Question: What style of plot is this figure drawn as?
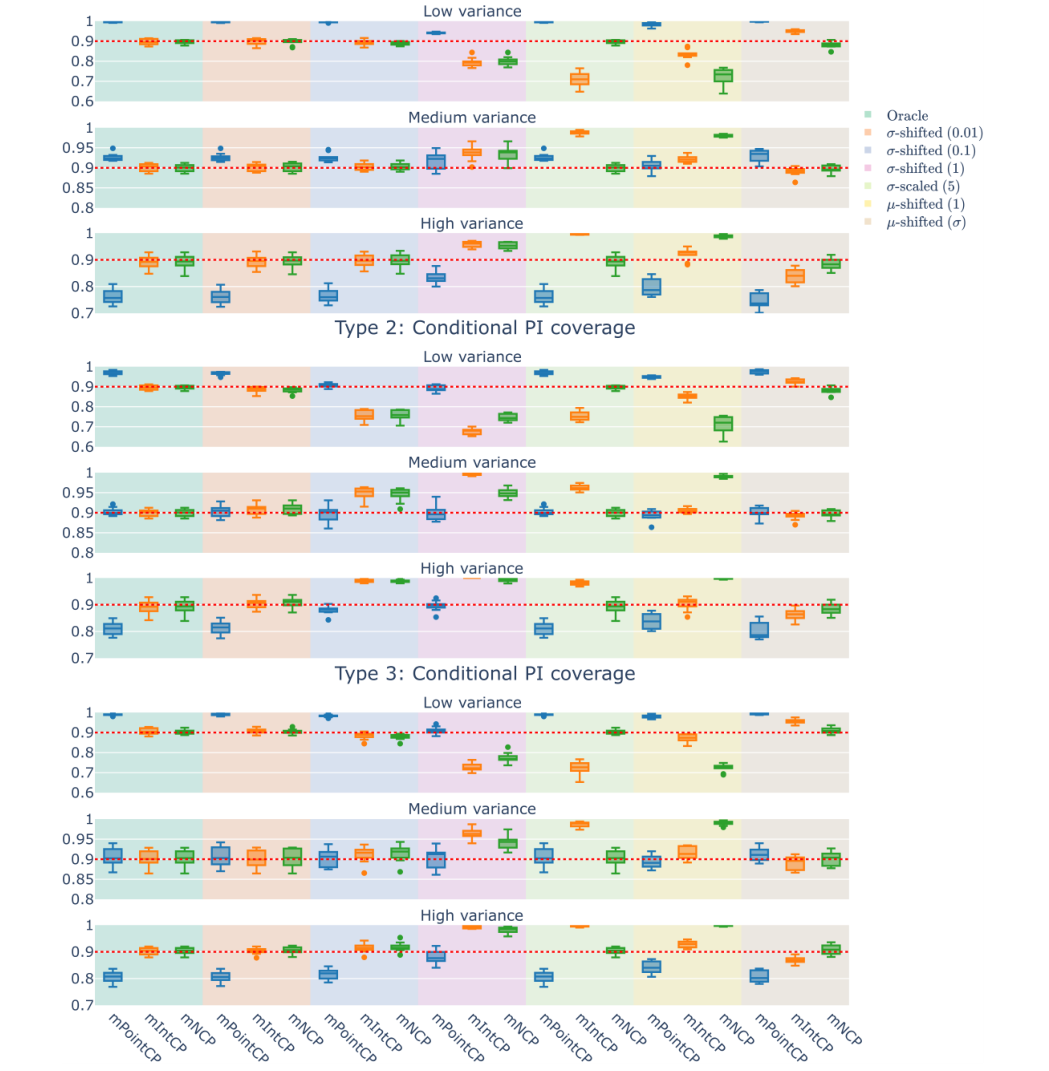
Answer: line